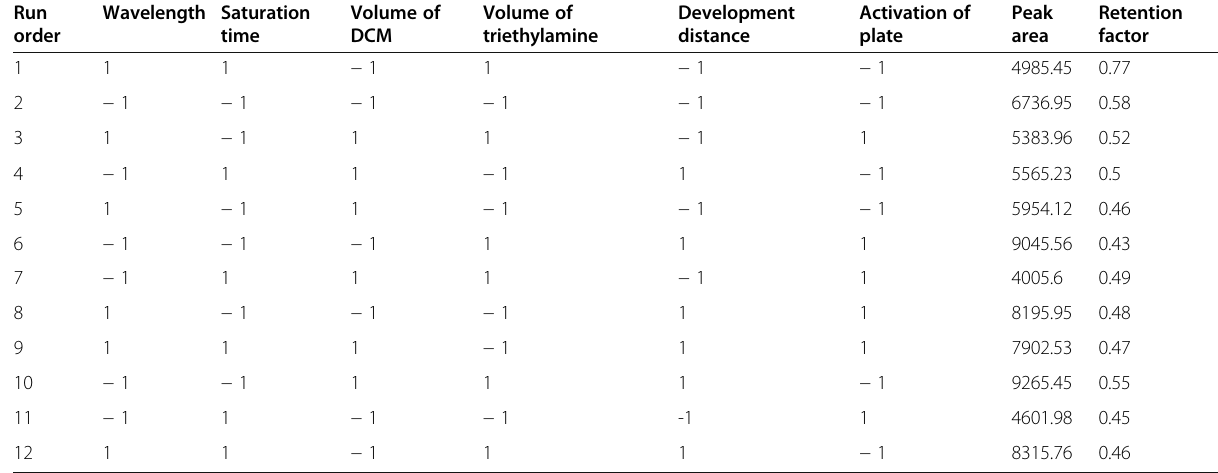
Table 2 Plackett-Burman design experimental runs for screening the significant independent variables affecting on the responses Run